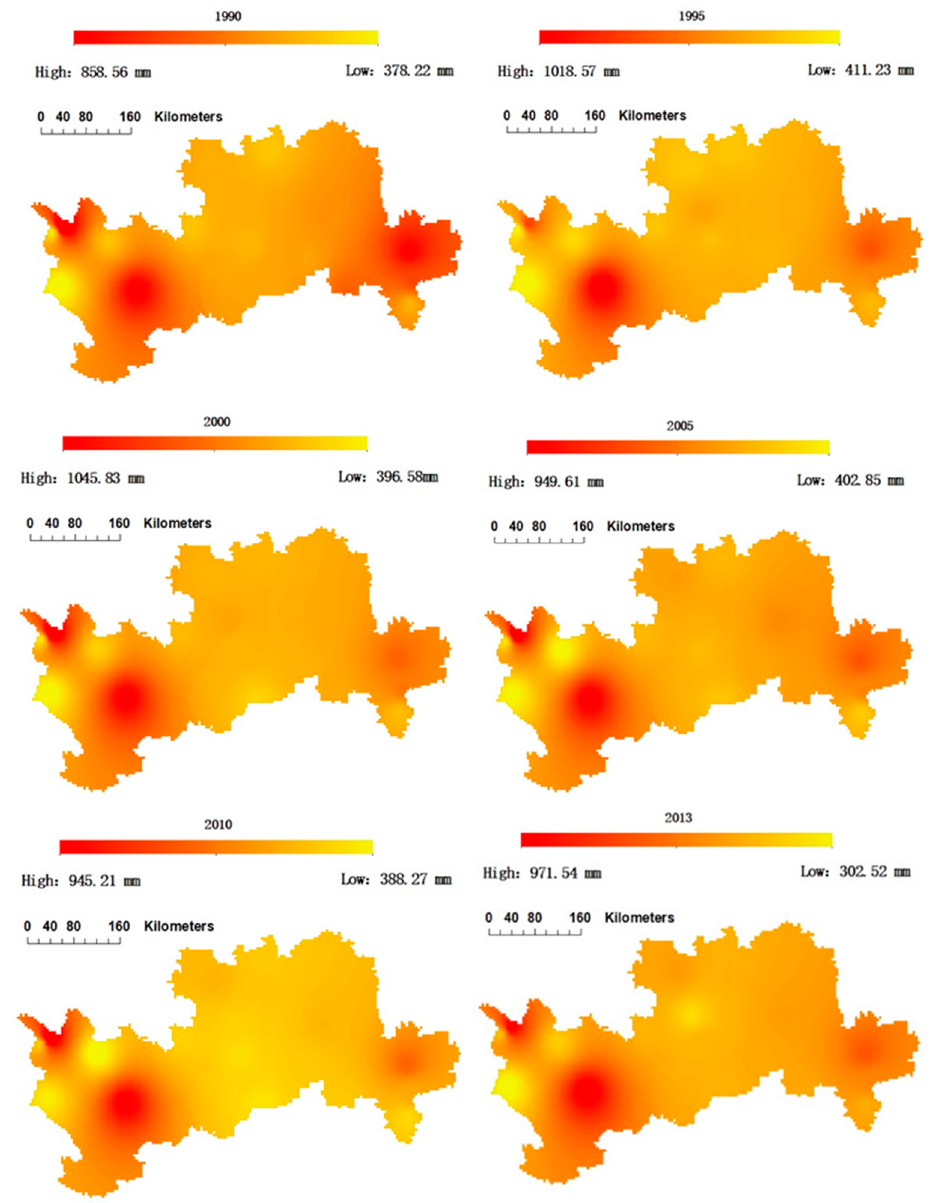
Figure 4. Spatial evolution of the water demand of apple trees in each province from 1990 to 2013.